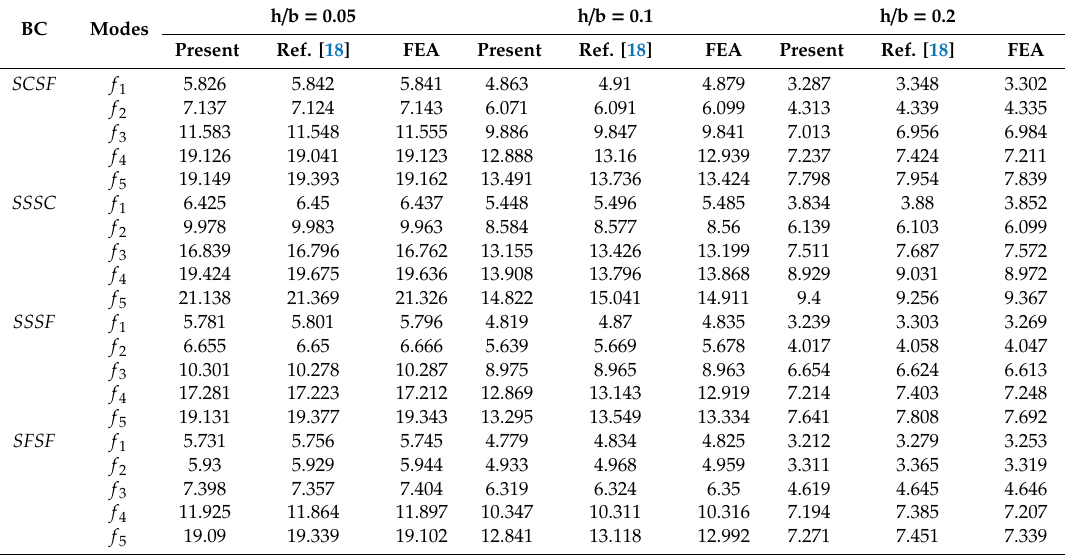
Table 5. Natural frequency parameters for rectangular laminated plates with SCSF, SSSC, SSSF and SFSF. h / b = 0.05 h / b = 0.1 h / b = 0.2 BC Modes Present Ref. [18] FEA Present Ref. [18] FEA Present Ref. [18] FEA